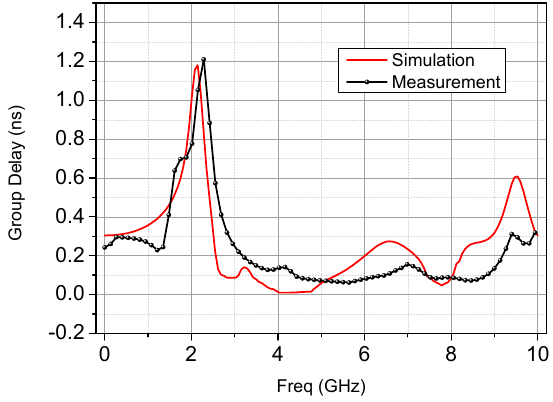
Figure 11. The simulation and measured values of group delay of the designed filter.